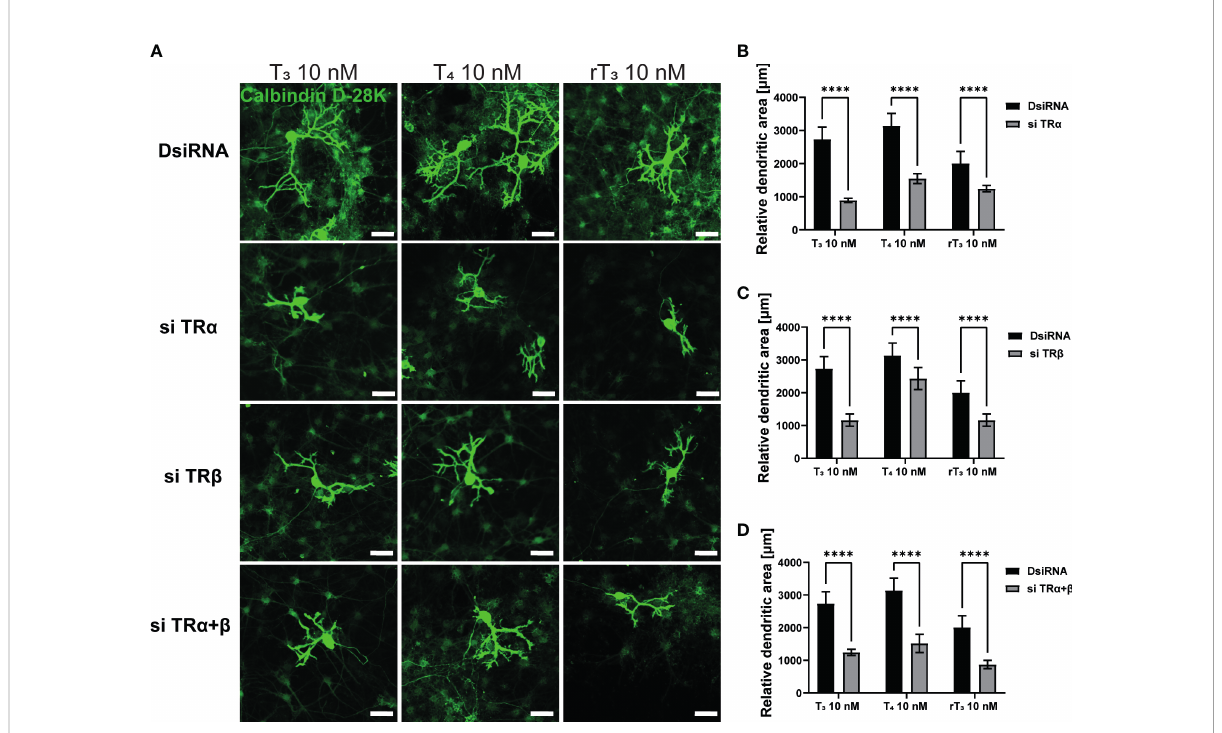
FIGURE 2 TR deletion impaired TH-augmented dendrite arborization of Purkinje cells. Cerebellar cells were cultured for 17 days, followed by an immunocytochemistry analysis with Calbindin D-28K (green). (A) Representative photomicrographs showing the effects of TH on the morphology of Purkinje cells after TR knockdown. Quantitative analysis of the effect of TH after exposure to TR a siRNA (B) , TR b siRNA (C) , and siRNA against TR a and TR b (D) on dendritic areas of Purkinje cells following TH treatment. ImageJ Fiji software (NIH) was used to quantify the dendritic area of Purkinje cells. Bars indicate 50 m m. Data are shown as the mean ± SEM and representative from at least three independent experiments. **** p < 0.0001 indicates statistical signi fi cance according to two-way or one-way ANOVA continued with post hoc Turkey test. See Supplementary Table